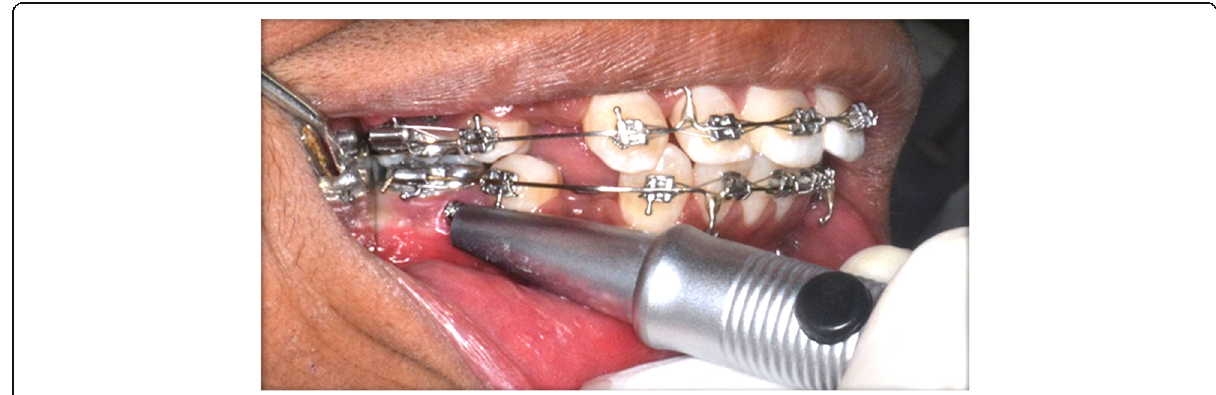
Fig. 3 Assessment of mobility of MSI with Periotest